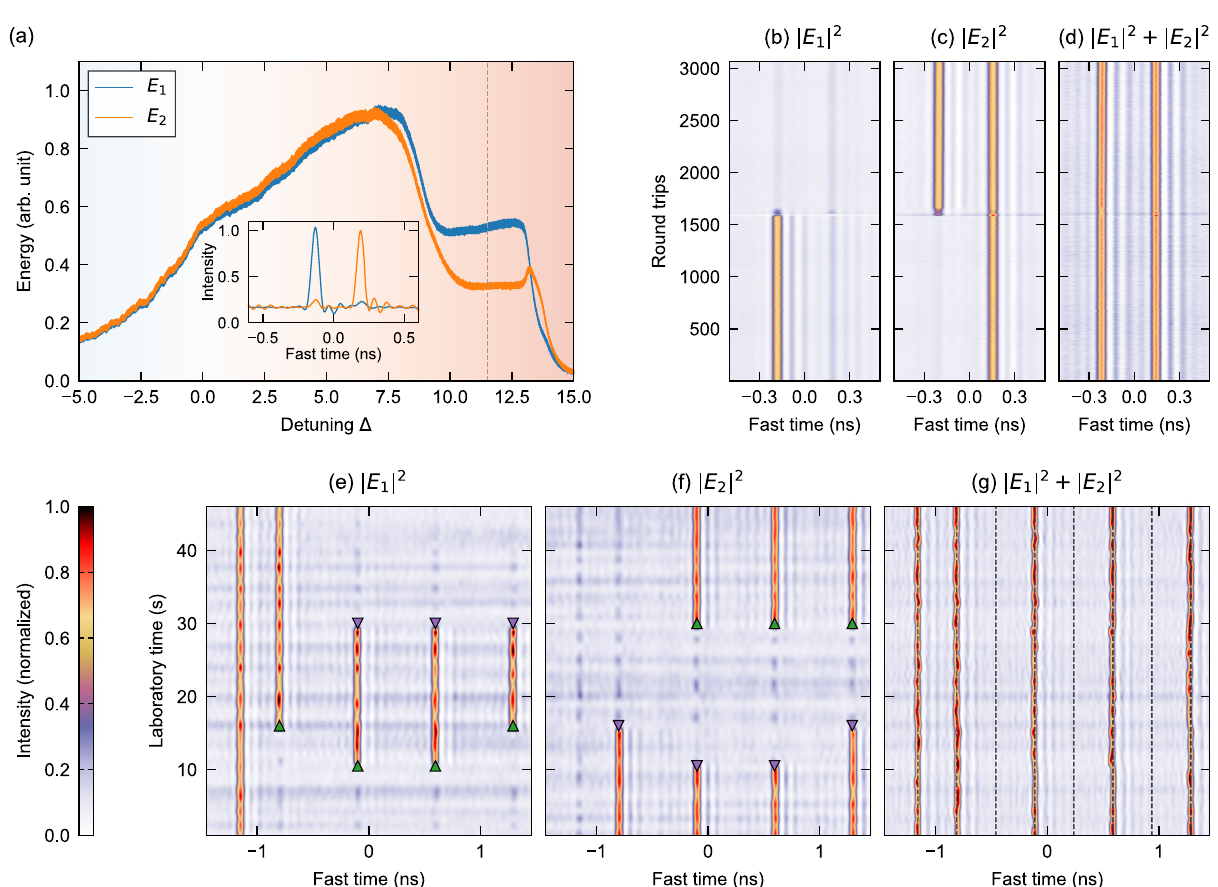
Fig. 4 Observation and deterministic switching of symmetry-broken CSs for X = 21. a Slow photodetector signals measured along the two cavity modes when scanning the laser frequency across a resonance. Inset shows an oscilloscope trace when the detuning is locked at Δ = 11.5 (gray dashed vertical line). b – d Space-time diagrams, showing how two CSs with different polarization states evolve from roundtrip-to-roundtrip: ( b ) E 1 component, ( c ) E 2 component, ( d ) total intensity. A polarization perturbation is applied on the driving fi eld at round trip 1600, and can be seen to enact deterministic switching of a CS from one polarization to the other. e – g Simultaneous and parallel polarization switching of several CSs: ( e ) E 1 component, ( f ) E 2 component, ( g ) total intensity. The green and magenta triangles highlight polarization increase and decrease perturbations, respectively. The colorbar applies to all ( b – g ) and the dashed vertical lines in ( g ) indicate the 2.87 GHz grid de fi ned by the pump phase